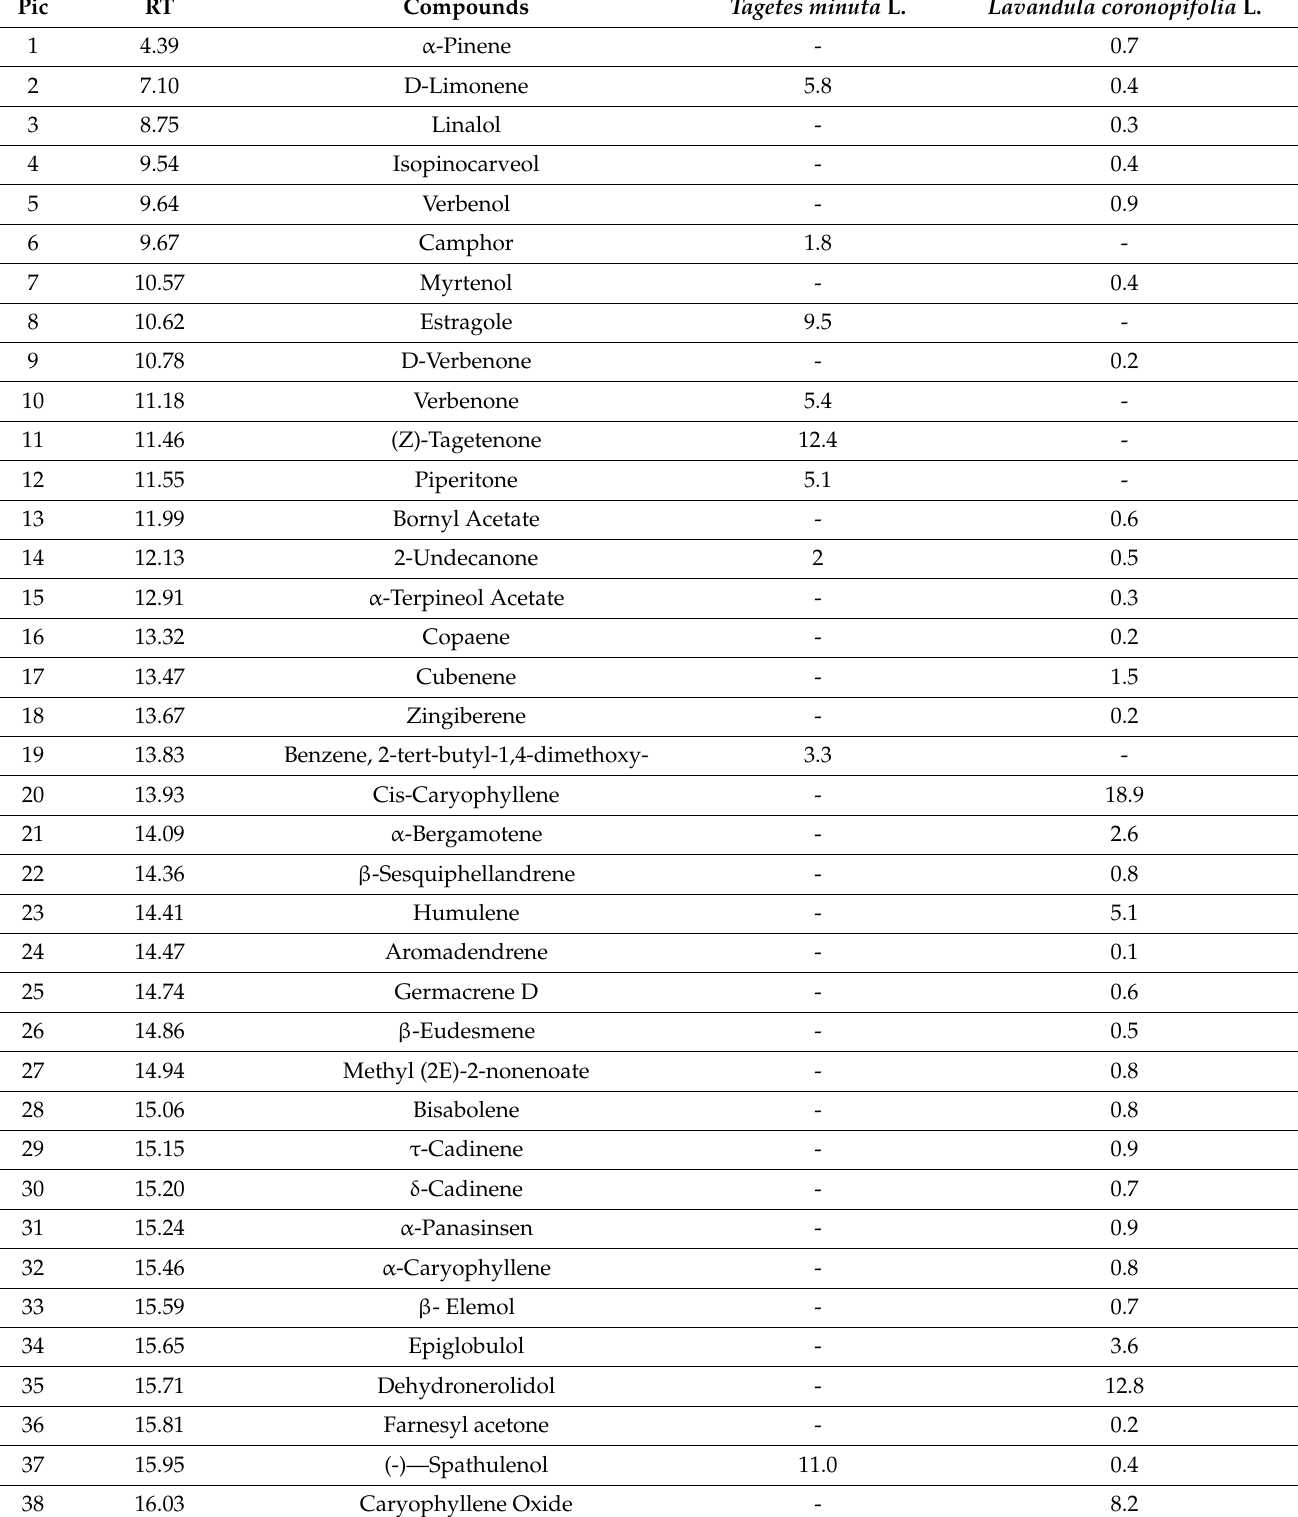
Table 3. Chemical composition of the essential oils of Tagetes minuta L. and Lavandula coronopifolia